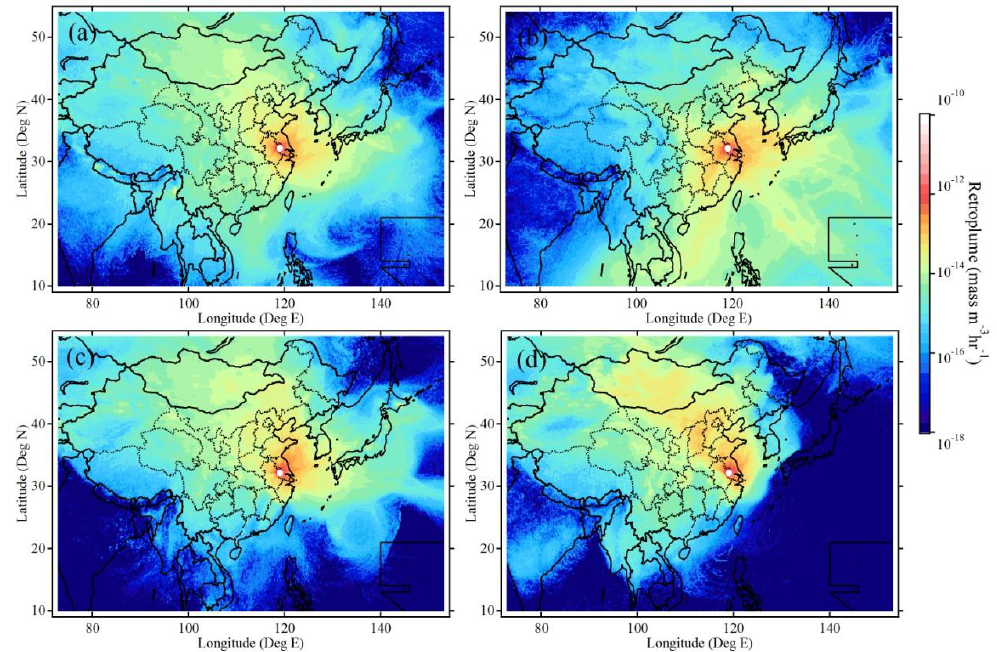
Fig. 2. Averaged retroplume (“footprint” residence time) showing transport pathways of air masses observed at Nanjing during (a) spring, Figure 2 . Averaged retroplume ("footprint" residence time ) showing transport 2 (b) summer, (c) autumn, and (d) winter for the 1yr period. Note: Red circle on the map shows the SORPES site location. pathways of air masses observed at Nanjing during ( a ) spring, ( b ) summer, ( c ) autumn, 3 and ( d ) winter, respectively, during the 1-year period. Note: Red cicle on the map 4 shows the site location. 5